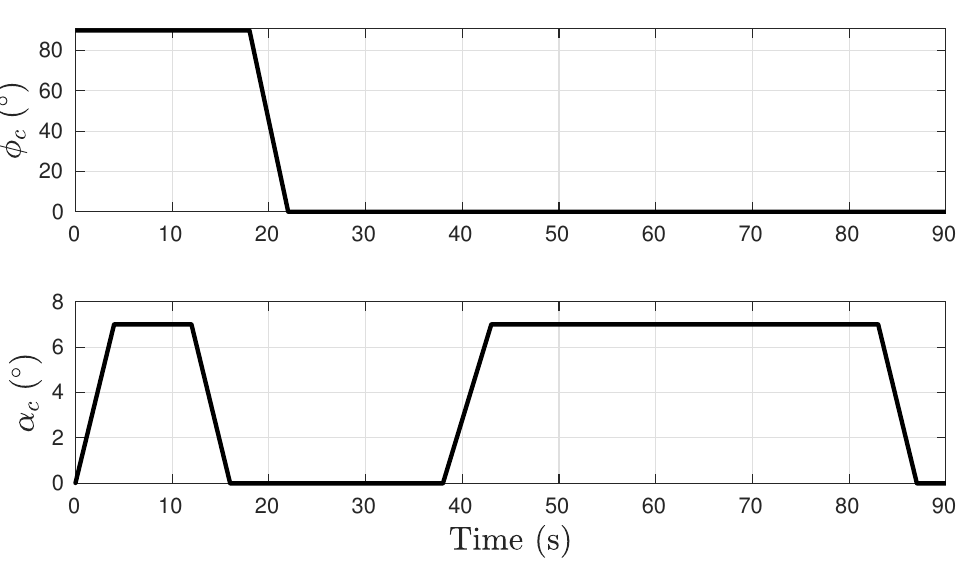
Figure 2. Nominal guidance commands for a fly-back booster during re-entry. The stage separation phase lasts from t = 0 to t = 18 seconds. This is marked by a ramp-up of commanded α while keeping φ = 90 ◦ . The reorientation phase involves ramping the commanded roll to zero while keeping the α = 0. The pull-up consists of ramping the commanded α to 7 ◦ . For the AMPC controllers, side slip ( β ) and yaw rate ( r ) are regulated, but only the yaw rate is regulated for the pole